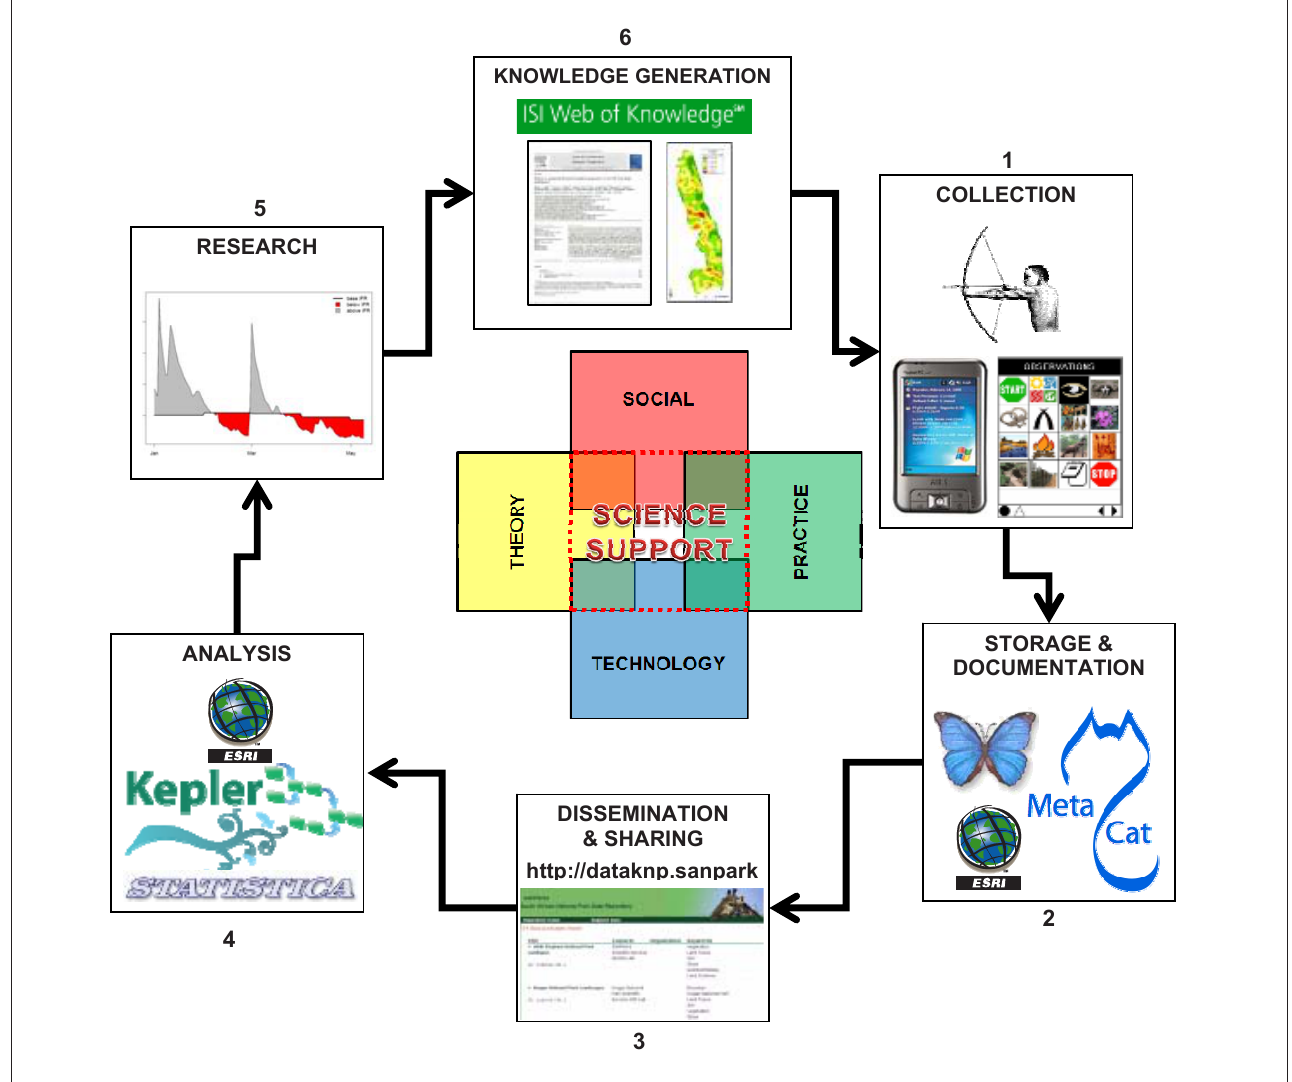
FIGURE 1: The South African National Parks (SANParks) science support process indicating the relationship between the six process